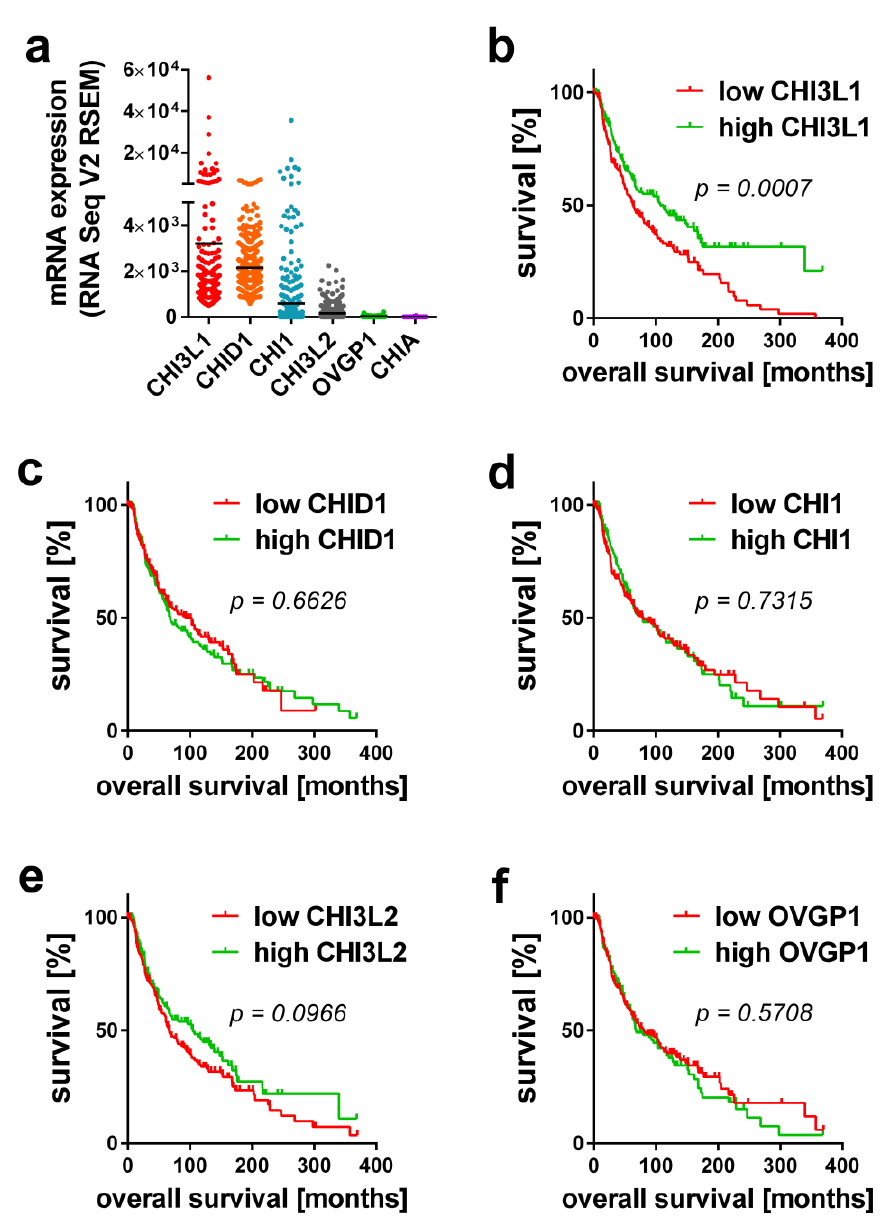
Figure 1. Analysis of public transcriptome data of melanoma patients. ( a ) Expression levels of mammalian chitinases in human melanoma tissue. ( b – f ) Kaplan-Meier curve presentation of the patients’ overall survival in correlation to the expression of ( b ) CHI3L1, ( c ) CHID1, ( d ) CHI1, ( e ) CHI3L2 and ( f ) OVGP1. Exact p -values of the performed log-rank test are indicated.